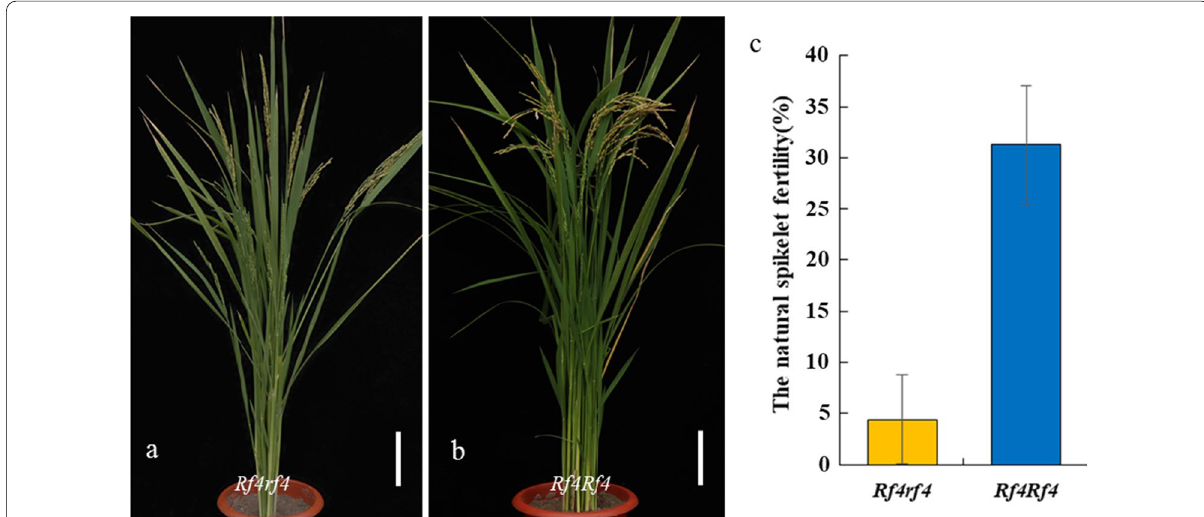
Fig. 4 Natural fertility levels of plants with different Rf genotypes in the WA-NipA/NIL Rf4 //NIL Rf4 population. a Mature plants with the Rf4rf4 genotype. b Mature plants with the Rf4Rf4 genotype. c Natural spikelet fertility levels of the WA-NipA/NIL Rf4 //NIL Rf4 plants. Scale bars and